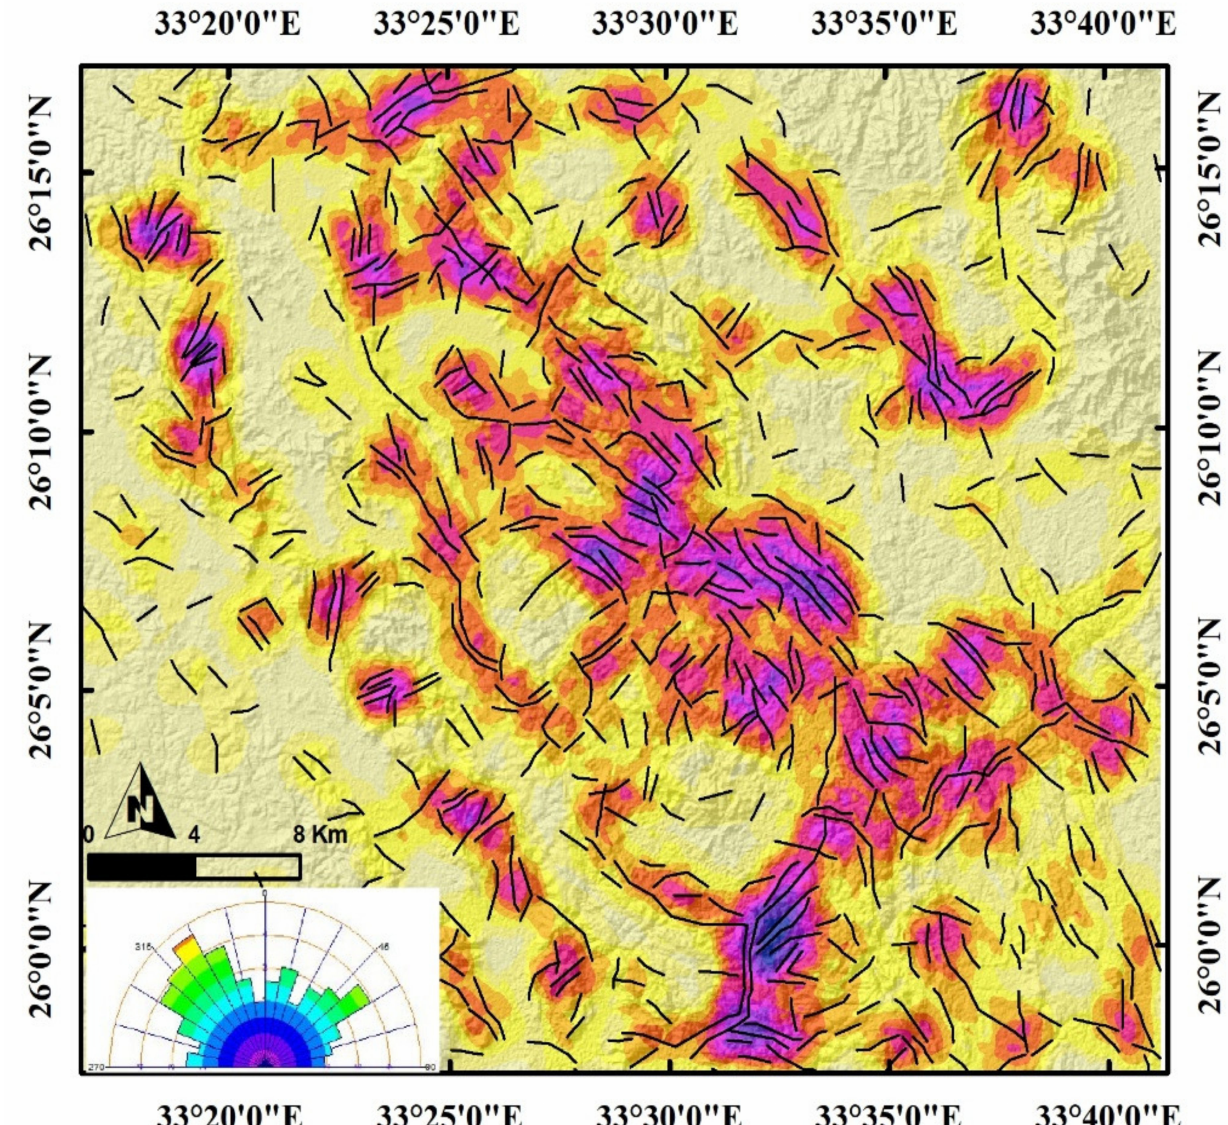
Figure 10. Density map of lineaments extracted automatically from ASTER band